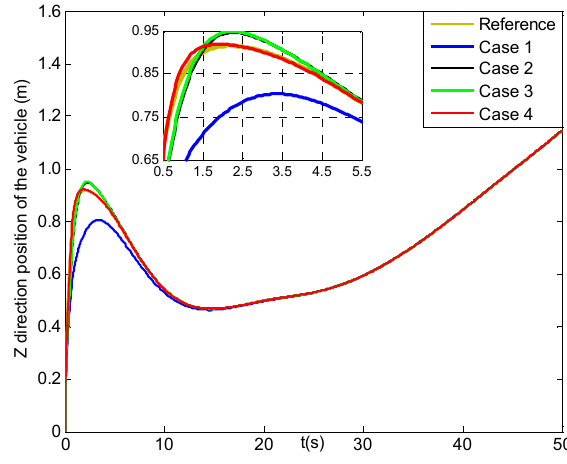
Figure 20. Z direction positions of the vehicle (four cases).